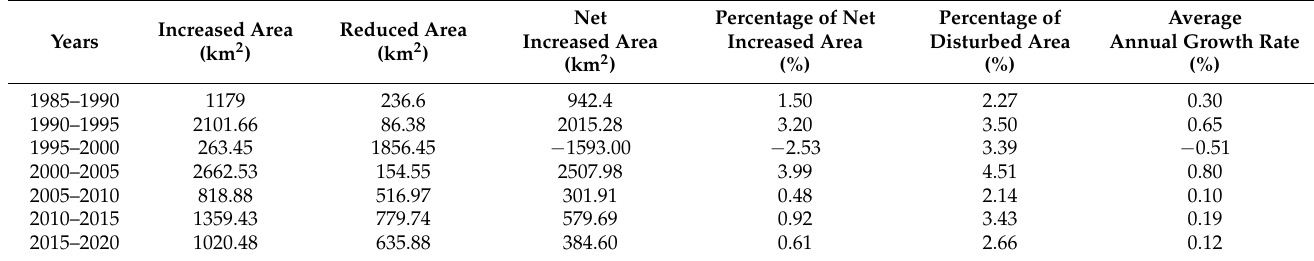
Table 5. The area’s change information concerning coniferous forests from 1985 to